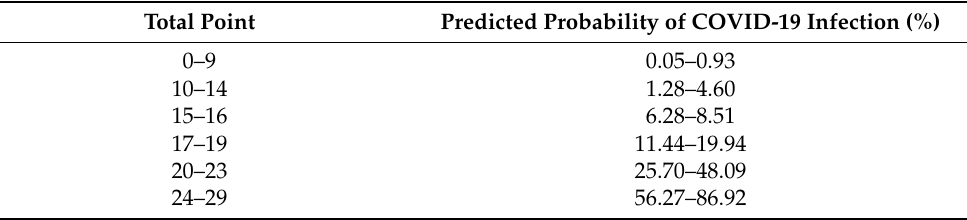
Table 4. The predictive score for SARS-CoV-2 infection after occupational exposure among hospital